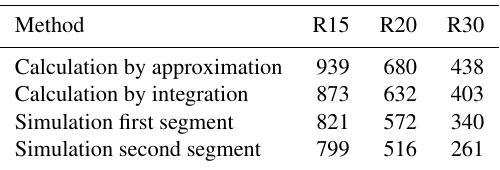
Figure 13. Simulated bending/unbending forces. Table 3. Bending/unbending forces (N) by different methods.